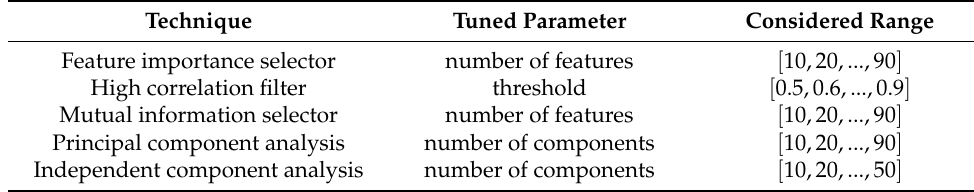
Table 2. Tuning parameters considered in feature selection